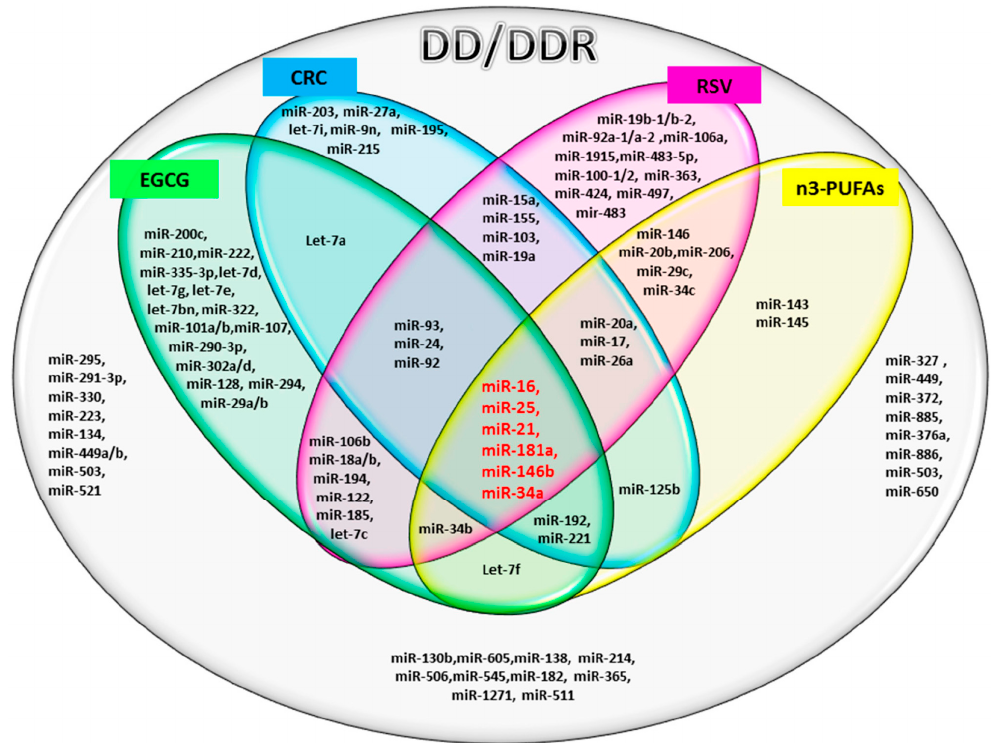
Figure 1. Venn diagram showing the microRNAs involved in DD/DDR (ellipse, grey) and identified as modulated by bioactive compounds: EGCG (epi-gallocatechin-3-gallate; green), CRC (curcumin; blue), RSV (resveratrol; pink) and n3-PUFAs (n3-polyunsaturated fatty acids, yellow). The common miRNAs, modulated by all four compounds, are indicated in red (miR-16, miR-25, miR-21, miR-181a, miR-146b, miR-34a).